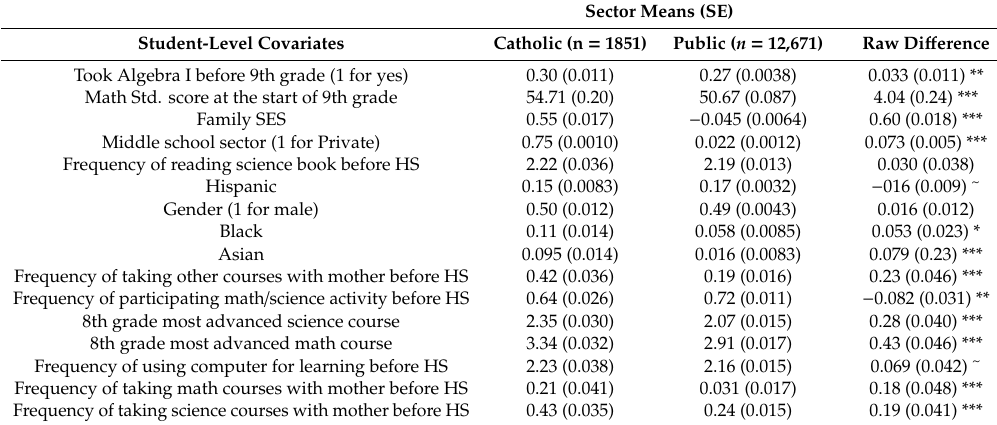
Table 3. Descriptive statistics for student-level